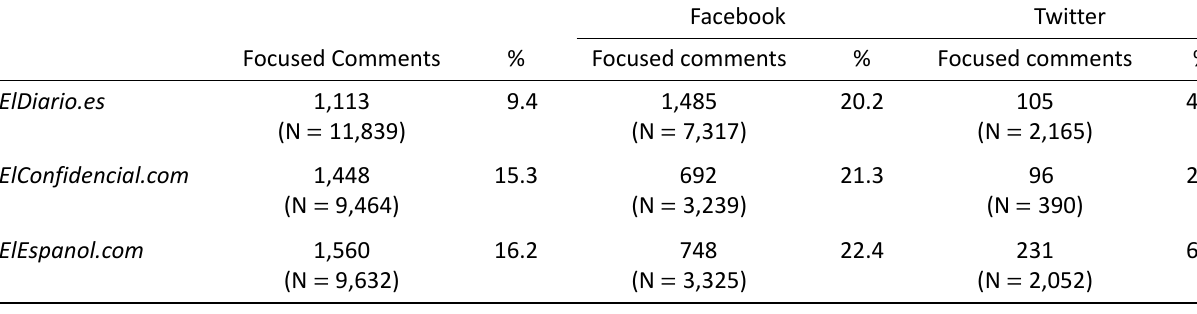
Table 5. Do users focus on the topic of the news